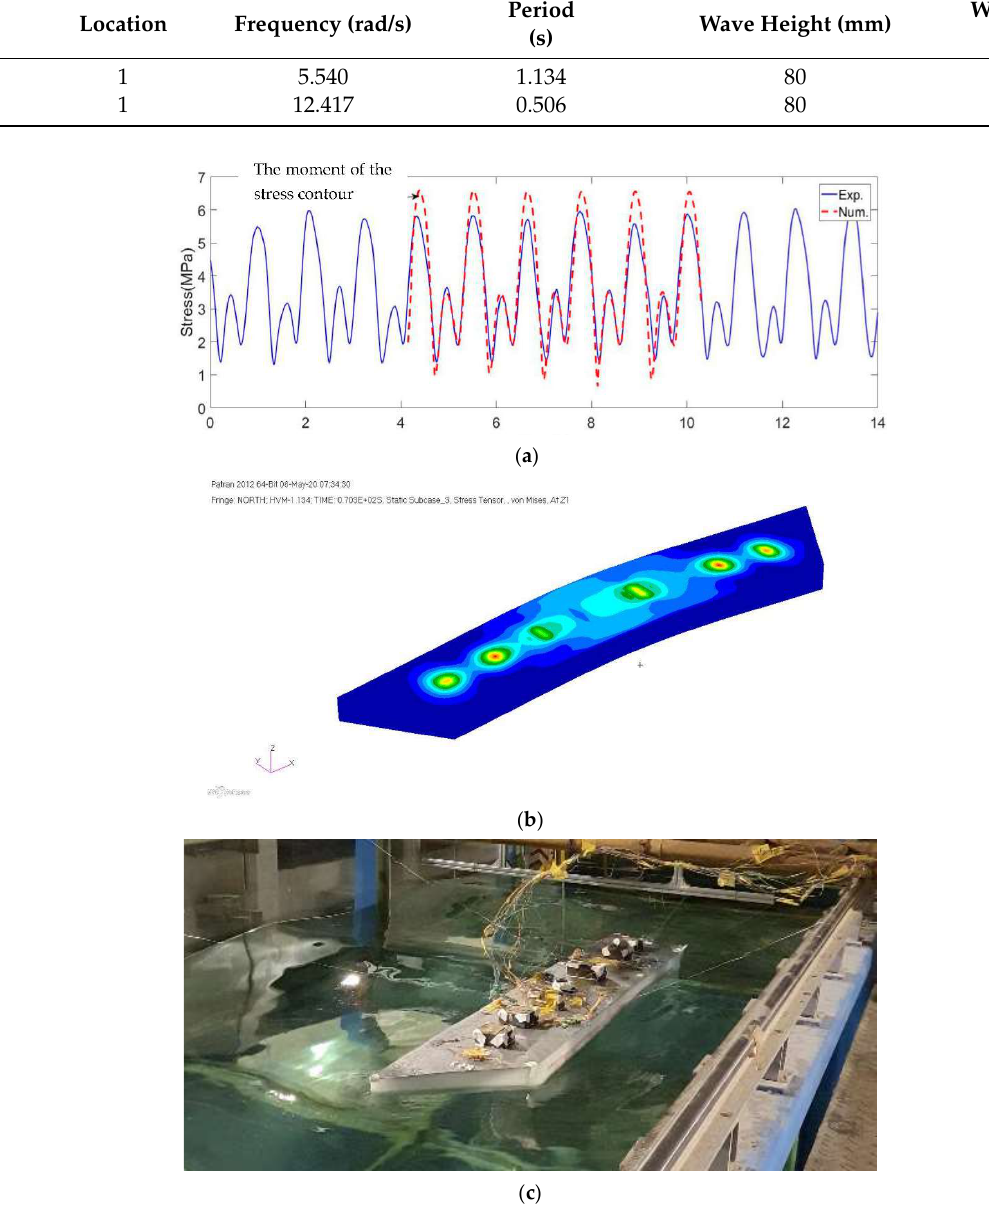
Figure 8. Result of Case 1. ( a ) The time domain history of stress in the measuring point No. 1 of case 1. ( b ) Stress contour at hogging of the case 1. ( c ) The experimental scene at hogging of the case 1.